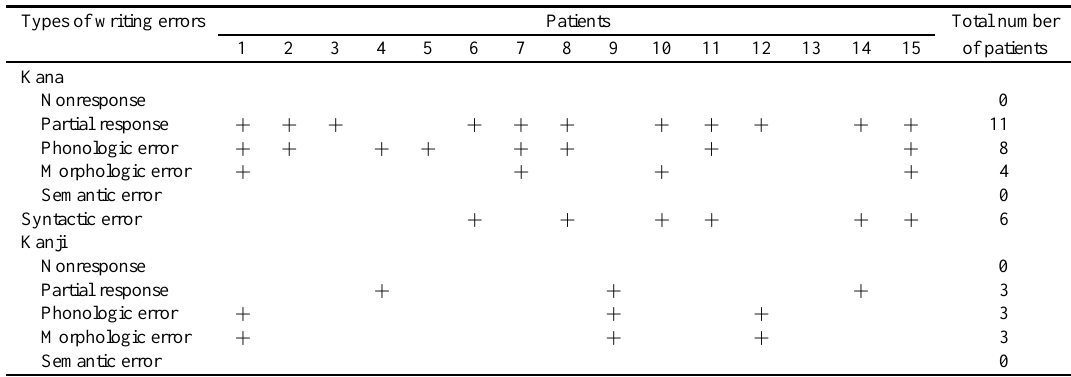
Table 2 Characteristics of writing errors in 15